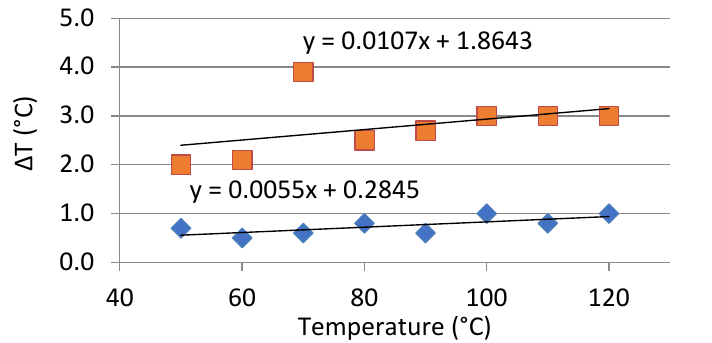
Figure 6. Calibration results of the Flir E6 and Flir E60bx cameras.